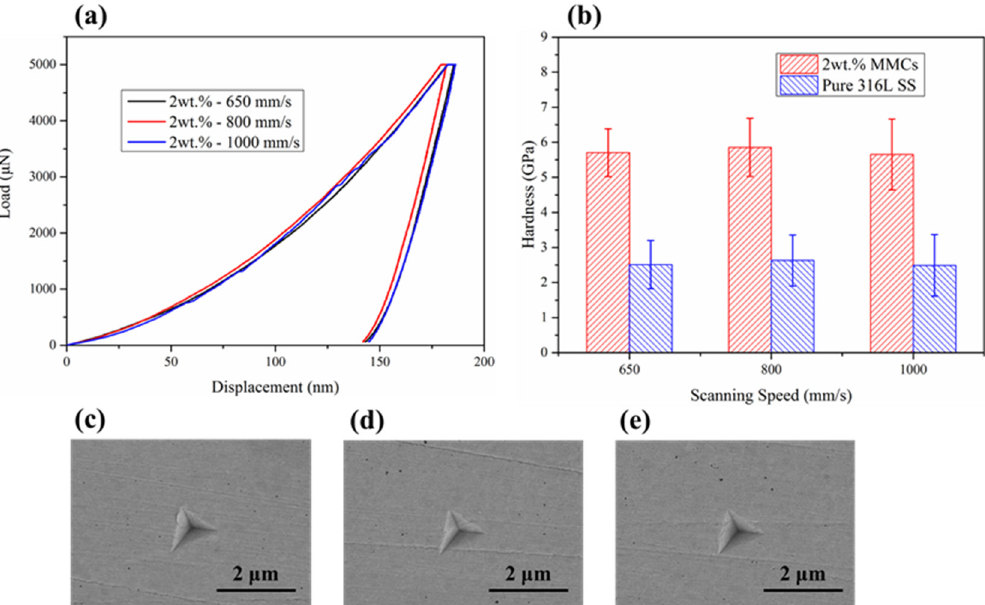
Figure 8. ( a ) the displacement–load curves of the SLM-fabricated composites; ( b ) the comparison of hardness between 316L stainless steel and its composite; and nanoindentation traces of ( c ) 650 mm/s, ( d ) 800 mm/s and ( e ) 1000 mm/s. Table 2. Young’s modulus ( E r ), hardness ( H ) and contact stiffness ( S ) of 2 wt.% HEA-reinforced 316L composites, and the hardness values obtained from other